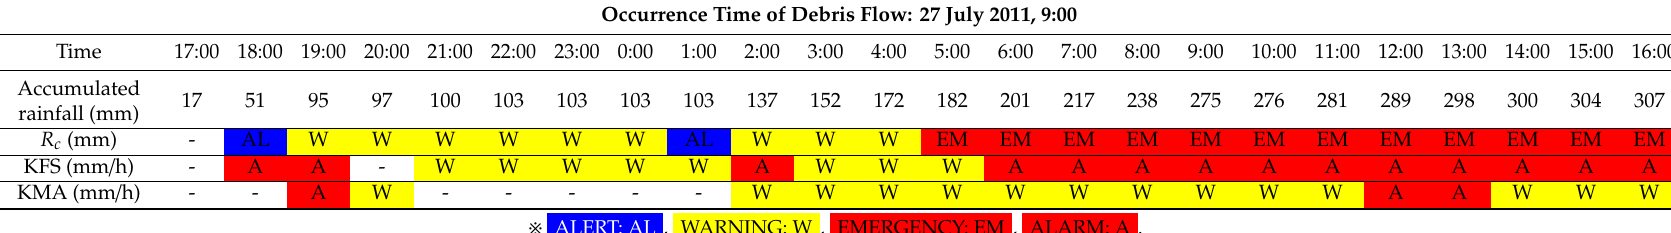
Table 6. Comparison of debris flow forecasting level results (Case